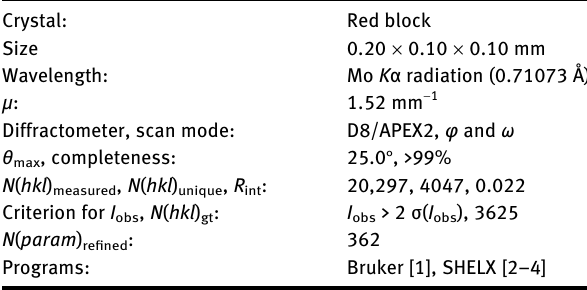
Table 1 contains crystallographic data and Table 2 contains the list of the atoms including atomic coordinates and displacement parameters.